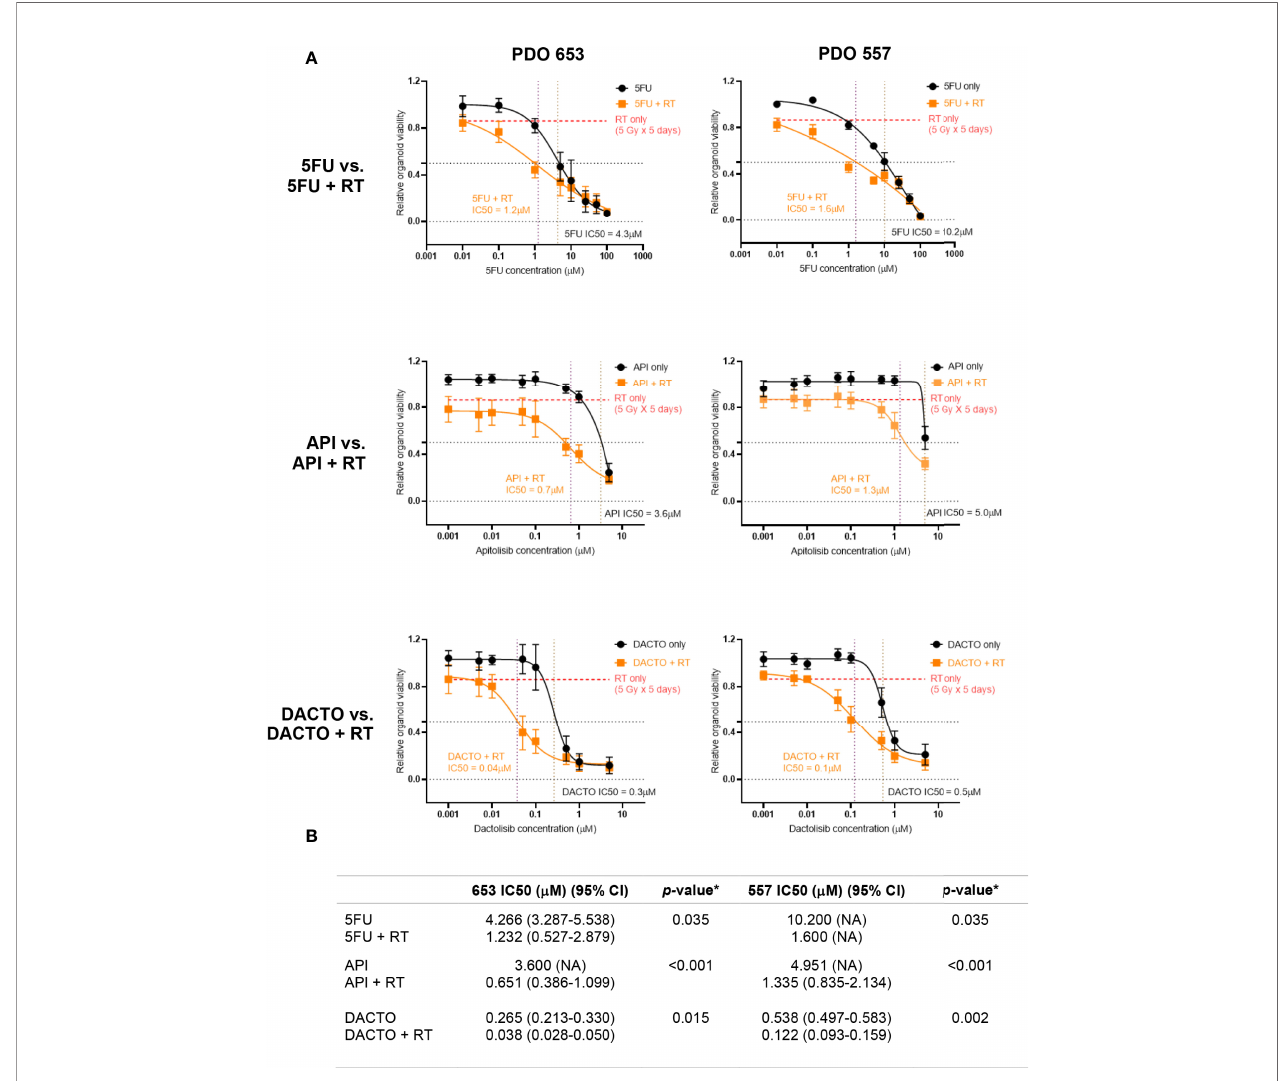
FIGURE 7 | Radiotherapy resistant PDO lines 557 and 653 treated with 5FU, Apitolisib and Dactolisib with or without radiotherapy. (A) PDO lines were plated at an estimated 5000 cells/well and treated with was treated with eight different concentrations of 5FU, Apitolisib (API) or Dactolisib (DACTO), with or without radiotherapy (5Gy fractions over 5 days). End-point cell viability was assessed using CellTiter-Glo ® 3D (Promega, USA) and chemiluminescence. The data is presented normalised to control (containing 0.1% DMSO). The x-axis represents log transformed drug dose concentrations ( m M). (B) Half maximal inhibitory concentrations (IC50) for each of the drugs with or without radiotherapy were obtained using Prism (Graphpad, USA). A statistically signi fi cant difference in radiosensitisation across all three drugs (radiotherapy effect; Two-way ANOVA test*, p < 0.0001) and between the different drug doses (drug effect: p <